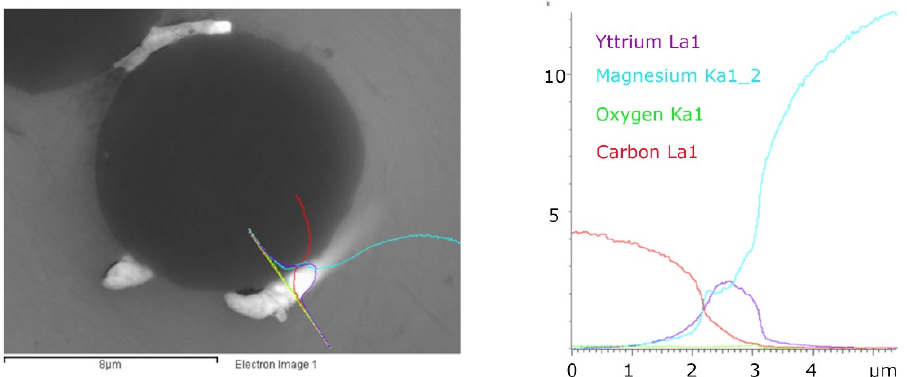
Figure 8. A line scan analysis of the fiber/matrix interface of the Mg1.8Y/Granoc composite with the reaction product. Analyzed interfacial area ( left ) and the signal intensity diagram of analyzed interfacial area ( right ). Colored lines are related to analyzed elements C (red), O (green), Mg (cyan), Y (violet), signal intensity is measured in kilocounts per second (kcps) plotted on the y-axis.